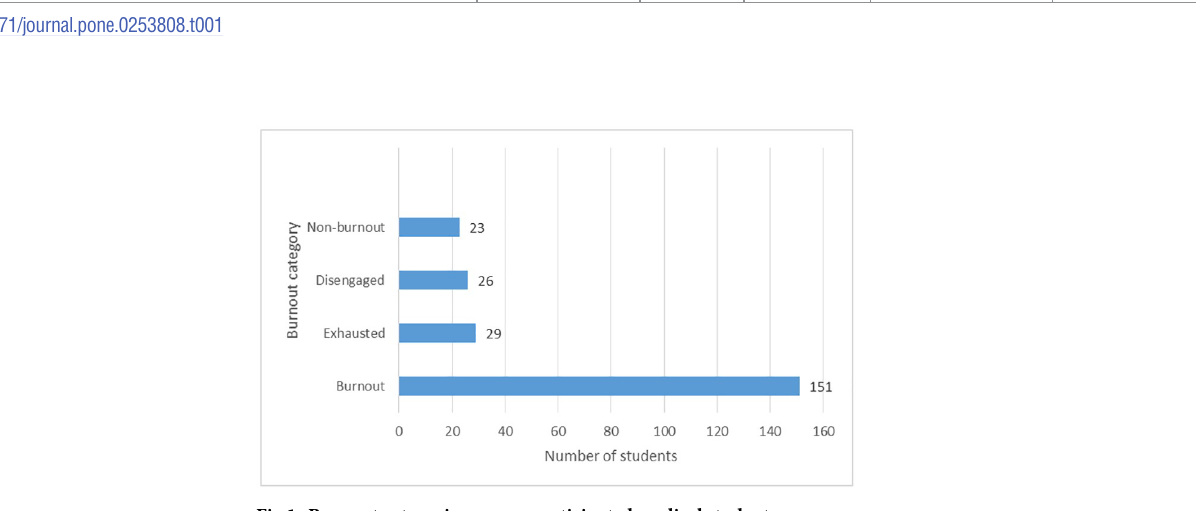
Fig 1. Burnout categories among participated medical